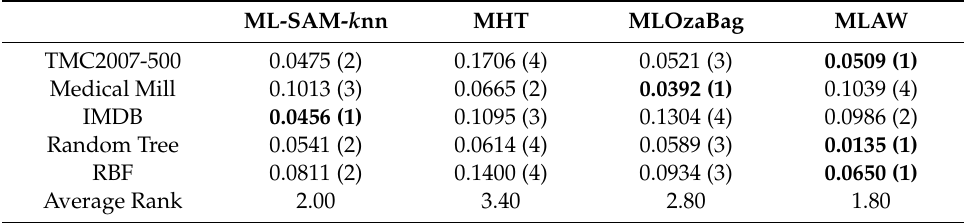
Table 4. Hamming loss of di ff erent algorithms.